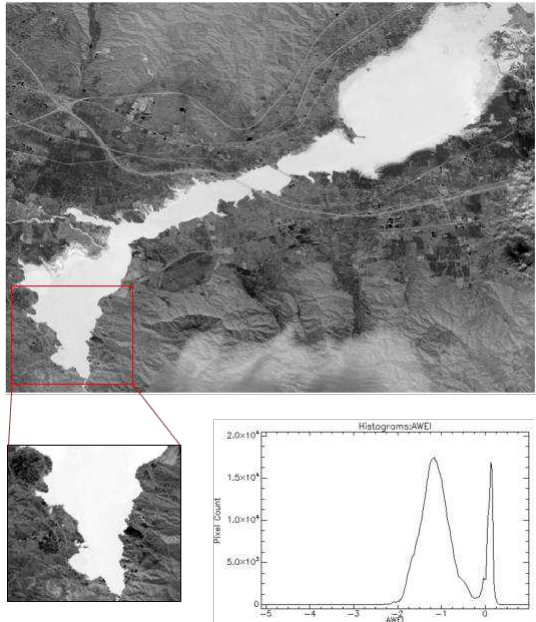
Figure 8. AHSI ’ s AWEI Image of Guanting Reservoir and Corresponding